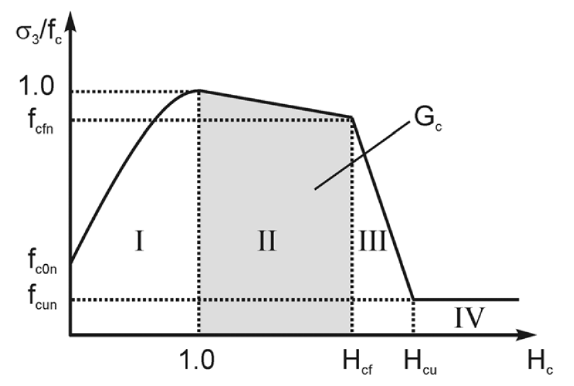
Figure 1. Normalized stress strain curve in compres- sion (taken from